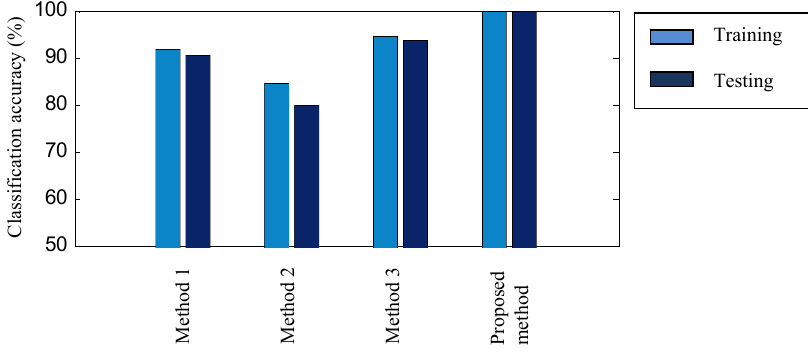
Figure 8. Accuracy comparison between Methods 1~3 and the proposed method for Case